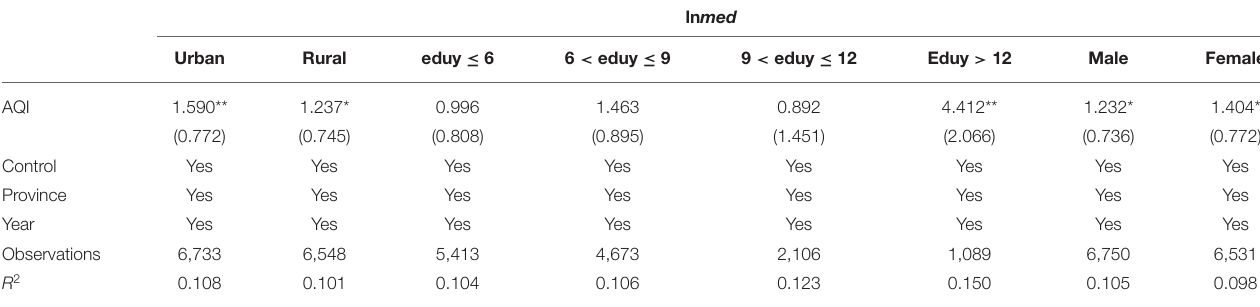
TABLE 3 | Impact of Air pollution on household medical expenses: by area, years of education, and gender.